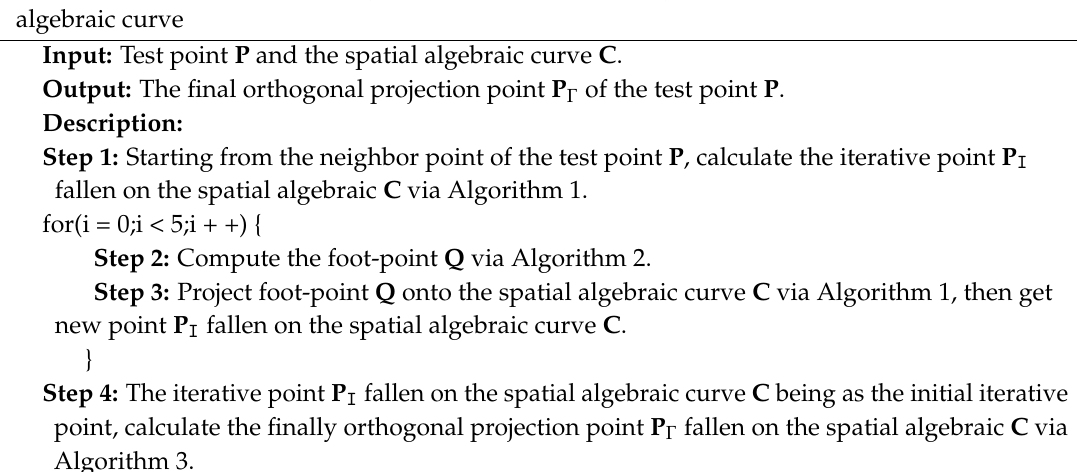
Algorithm 4: A complete algorithm for point orthogonal projection onto a spatial algebraic curve